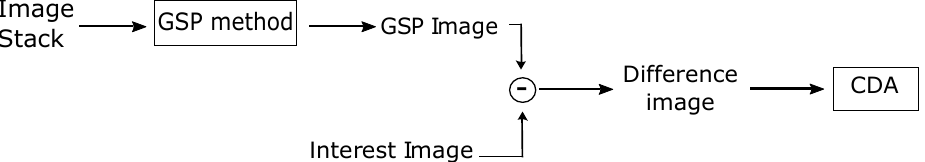
Figure 1. Processing scheme for change detection. The ground scene prediction (GSP) image is the reference image and the interest image is the surveillance image. The change detection algorithm (CDA) is performed applying thresholding and morphological operations in the difference image. Note that the difference image is based on the subtraction between single-look image pixels as a consequence of the stability in backscattering using a wavelength-resolution synthetic aperture radar (SAR)